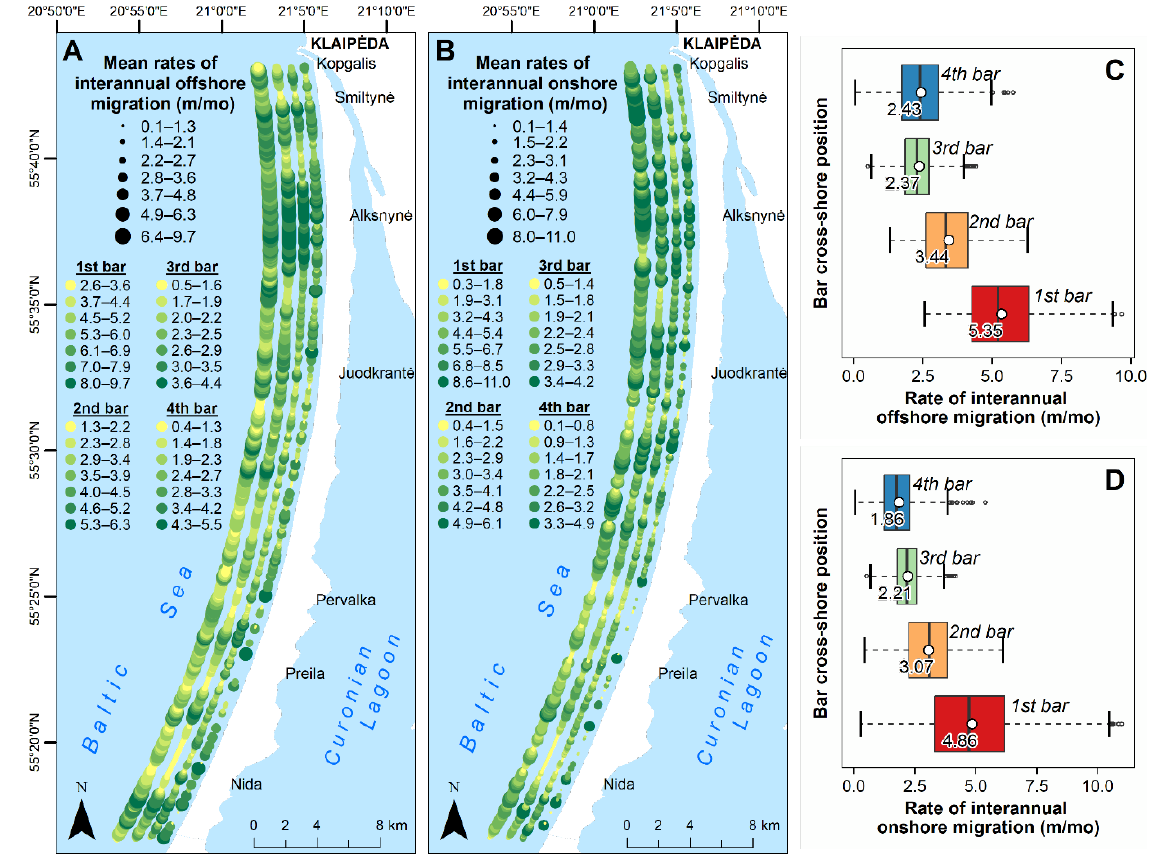
Figure 6. Alongshore variability in rates (m/month) of interannual offshore ( A ) and onshore ( B ) migration. The colour scale indicates mean interannual migration rates for different bar cross-shore positions (1st to 4th bar). It is set separately for each position and explained by the legend below the underlines. The 1st bar is depicted furthest from the shore and the 4th bar − closest. Boxplots illustrate the statistical distribution of interannual offshore ( C ) and onshore ( D ) migration rates by the cross-shore position of the bars.